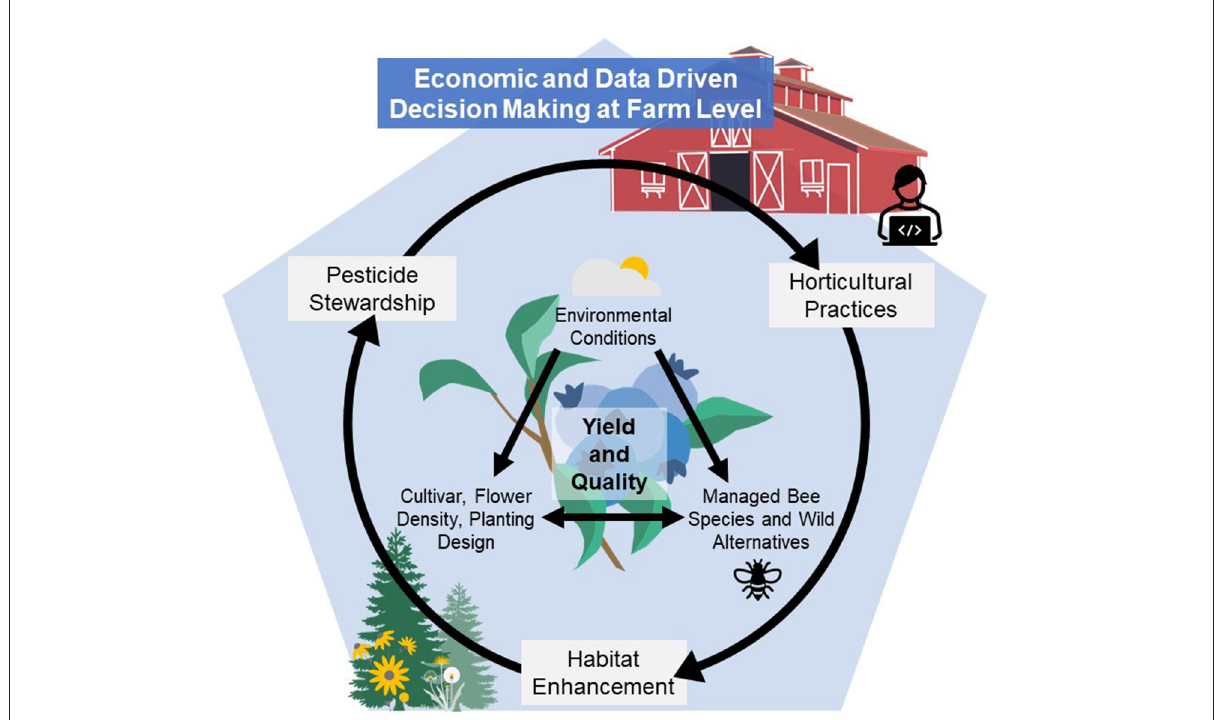
FIGURE1 Highbush blueberry yield and quality depends on pollination success, which is affected by components within this blended Integrated Crop Pollination (ICP) framework that includes use of common and alternative managed pollinator species, wild pollinators, habitat enhancement, pesticide stewardship, and horticultural practices. Floral traits, environmental conditions, on-farm economics, and the potential use of decision-aid technologies all have the potential for unique impacts on blueberry pollination, thus requiring a deeper understanding of how they impact pollination success and contribute to economic and effective evidenced-based decisions at the farm